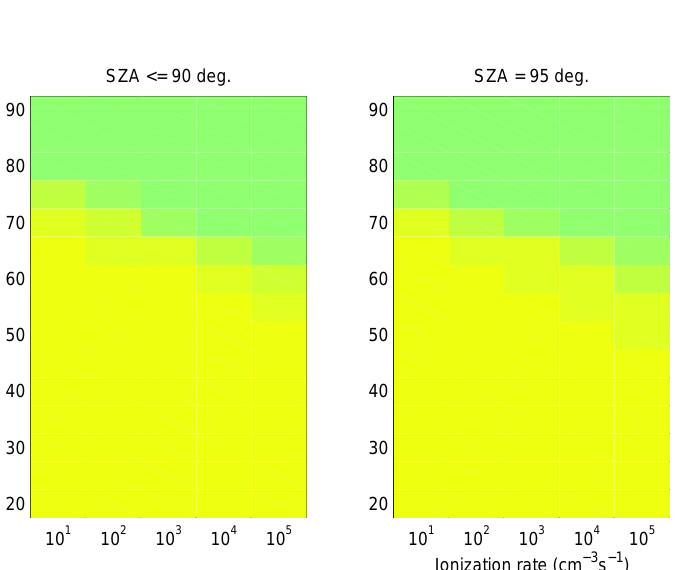
/Q for January 2